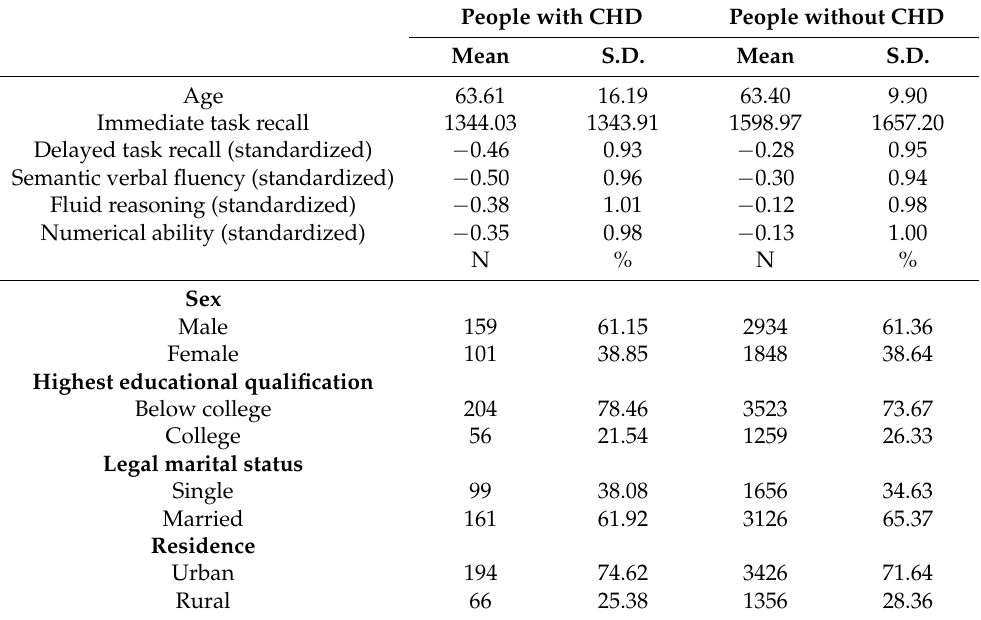
Table 1. Descriptive statistics of demographic characteristics and cognitive performance for people with and without CHD.